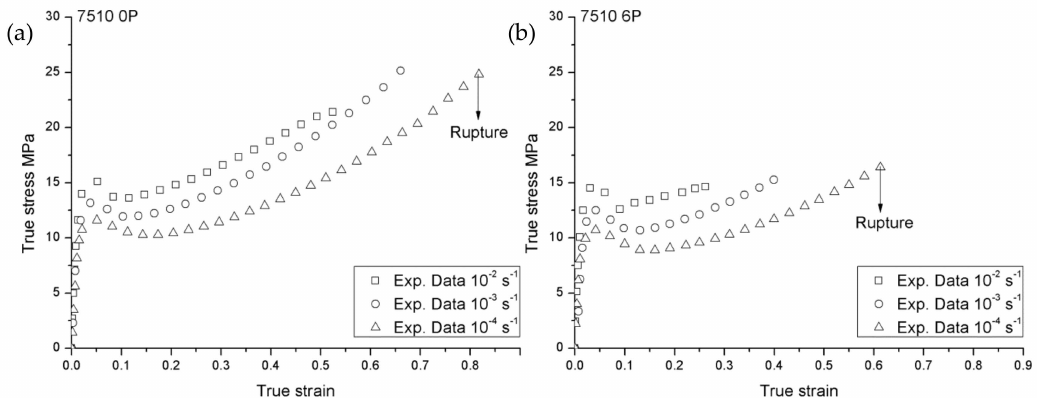
Figure 1. True stress vs. true strain responses of 108MF97 ( a ) 0P and ( b ) 6P, at three di ff erent strain rates.